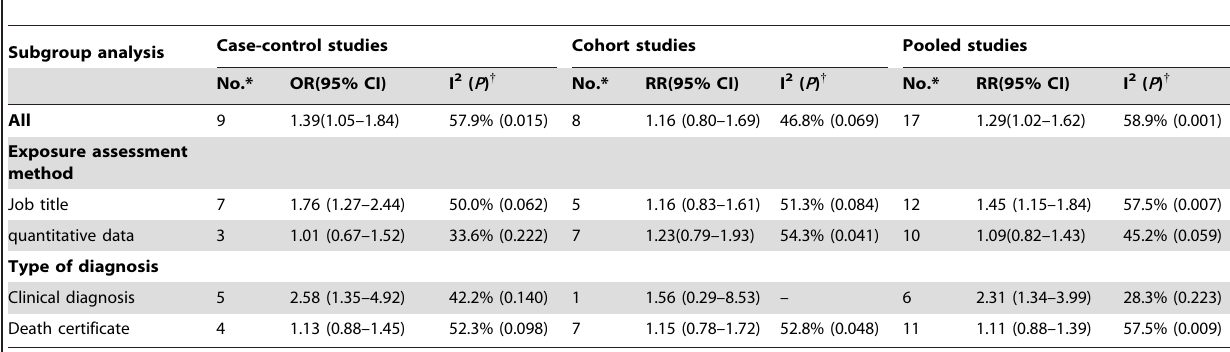
Table 2. Pooled estimates of the association between occupational exposure to ELF-EMF and ALS risk in pooled analyses and separate